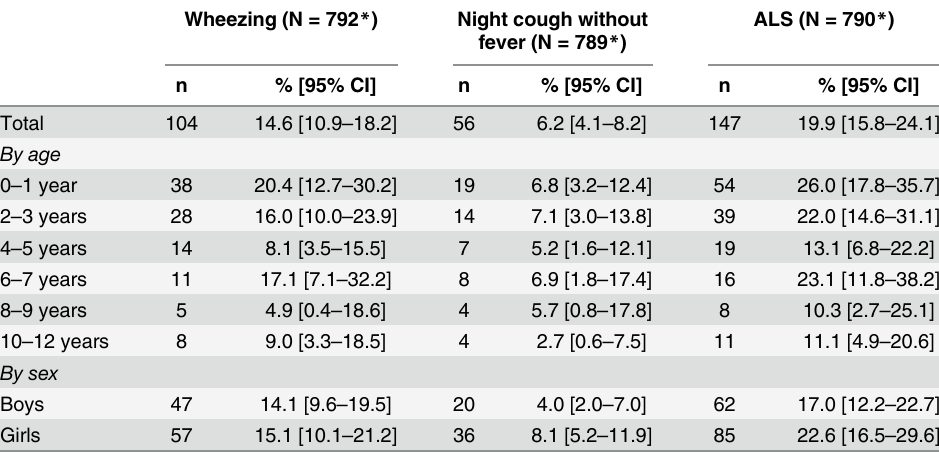
Table 2. Weighted prevalence of asthma-like symptoms